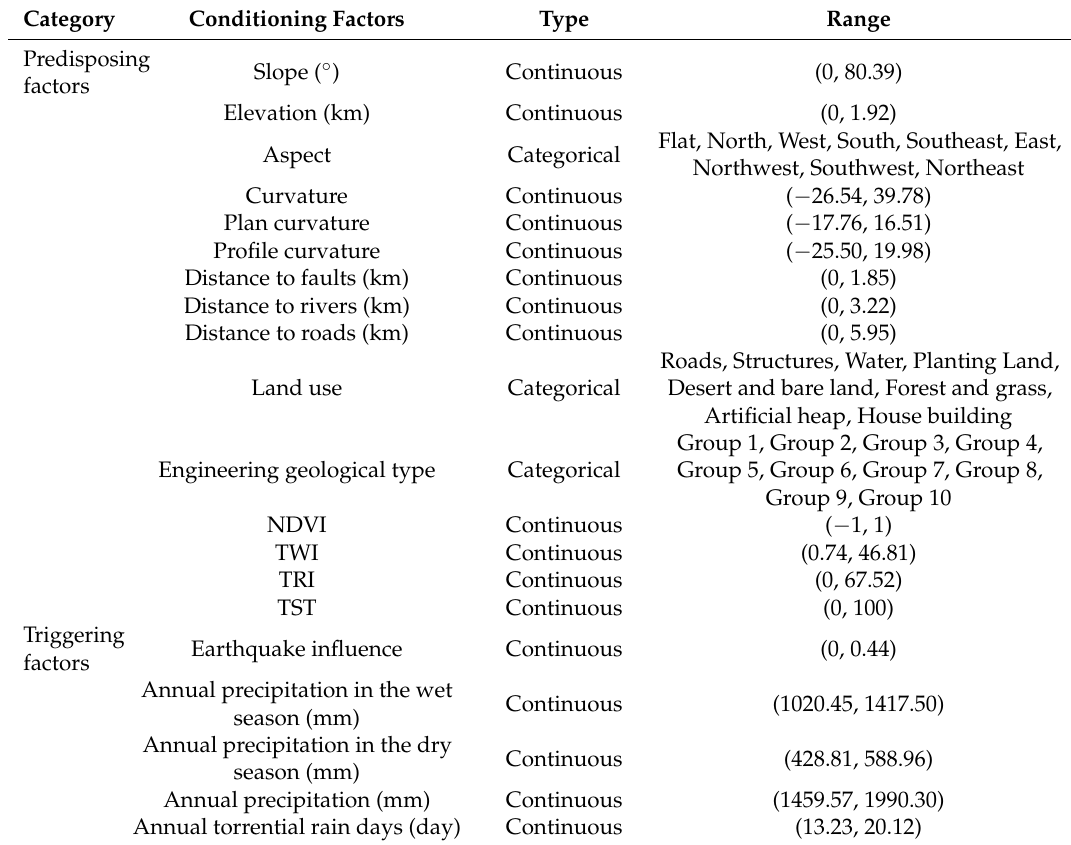
Table 1. Landslide conditioning factors in this